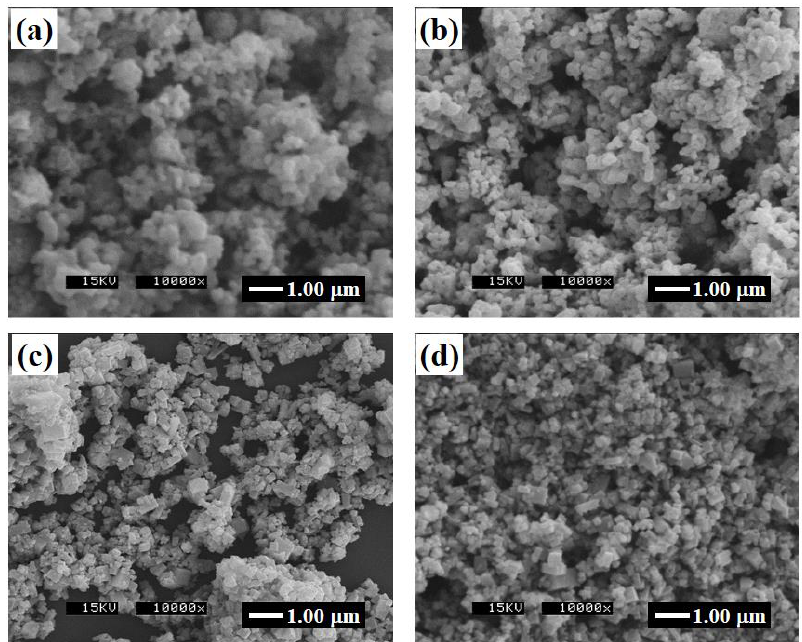
Figure 2. FE-SEM photomicrographs of KNN particles synthesized in glycothermal conditions at various reaction temperatures for 12 h: ( a ) 80 °C, ( b ) 120 °C, ( c ) 160 °C, and ( d ) 200 °C.